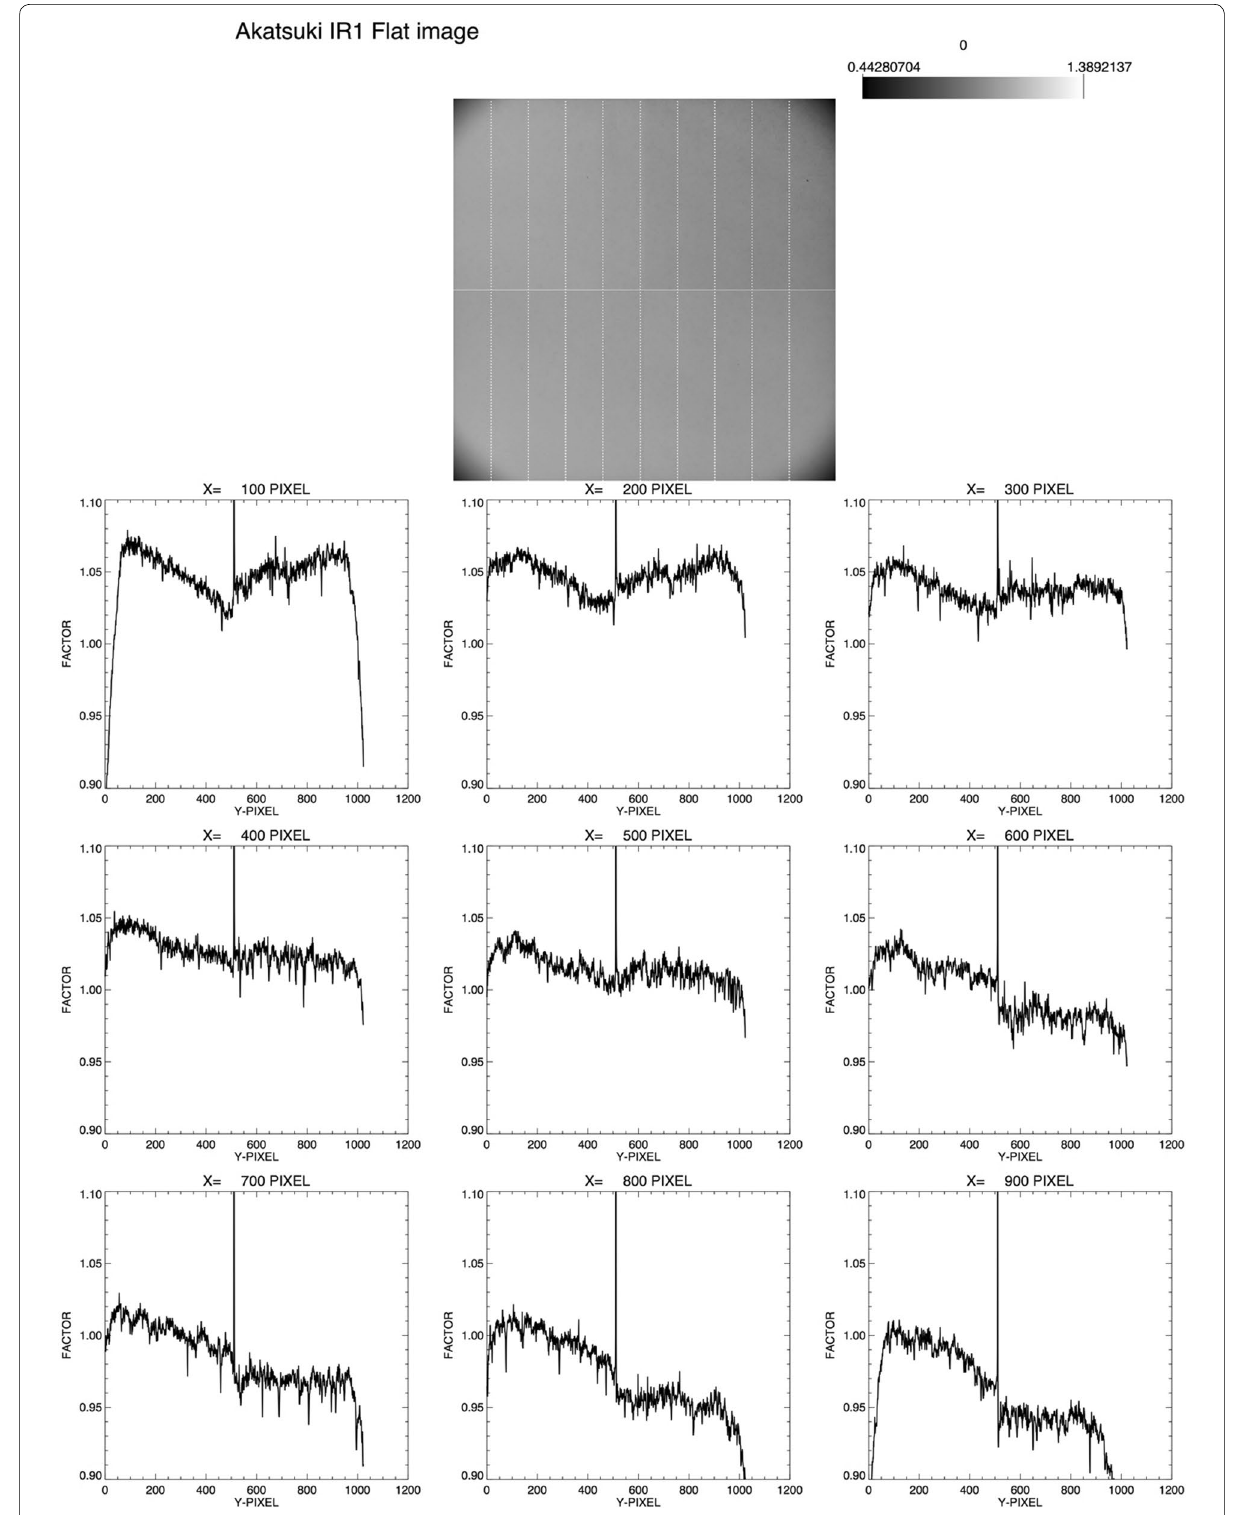
Fig. 9 Vertical cross section of the flat field. The top image is the flat field in relative unit. The nine panels on the bottom show intensity along the vertical dotted line (at x 100–900) in the top image. Factor indicates relative =